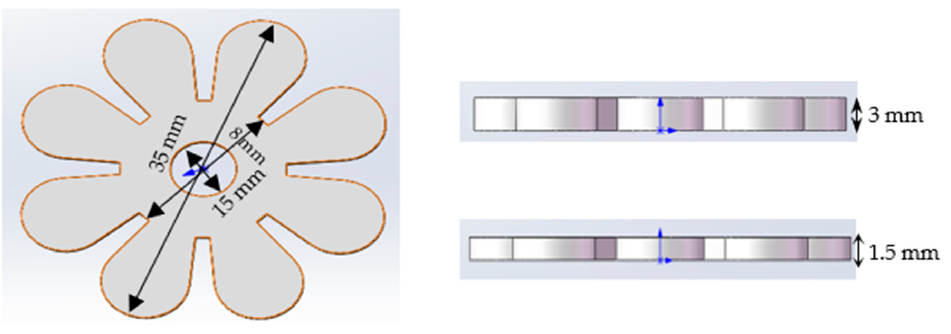
Figure 3. The design of the bilayer fl ower.